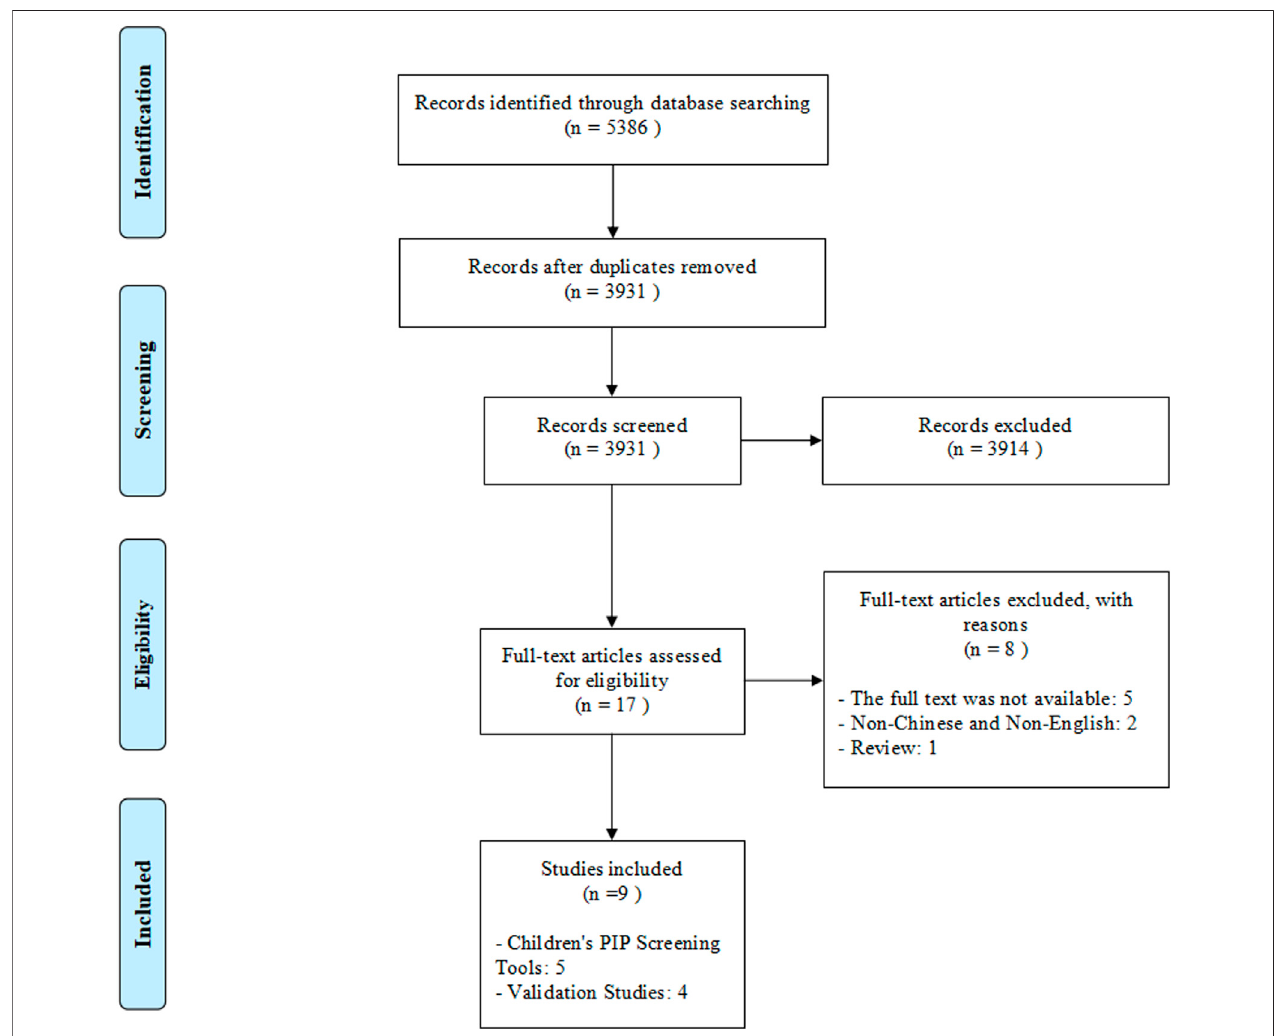
FIGURE 1 | Flow diagram of the study selection